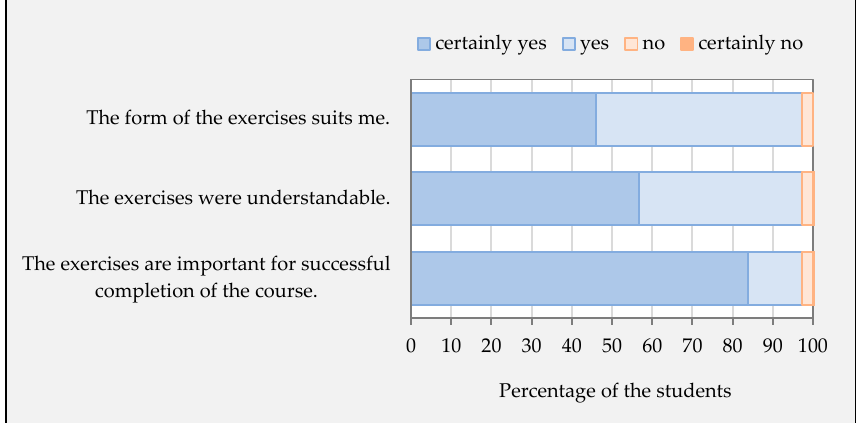
Figure 15. The students’ evaluation of completed exercises.